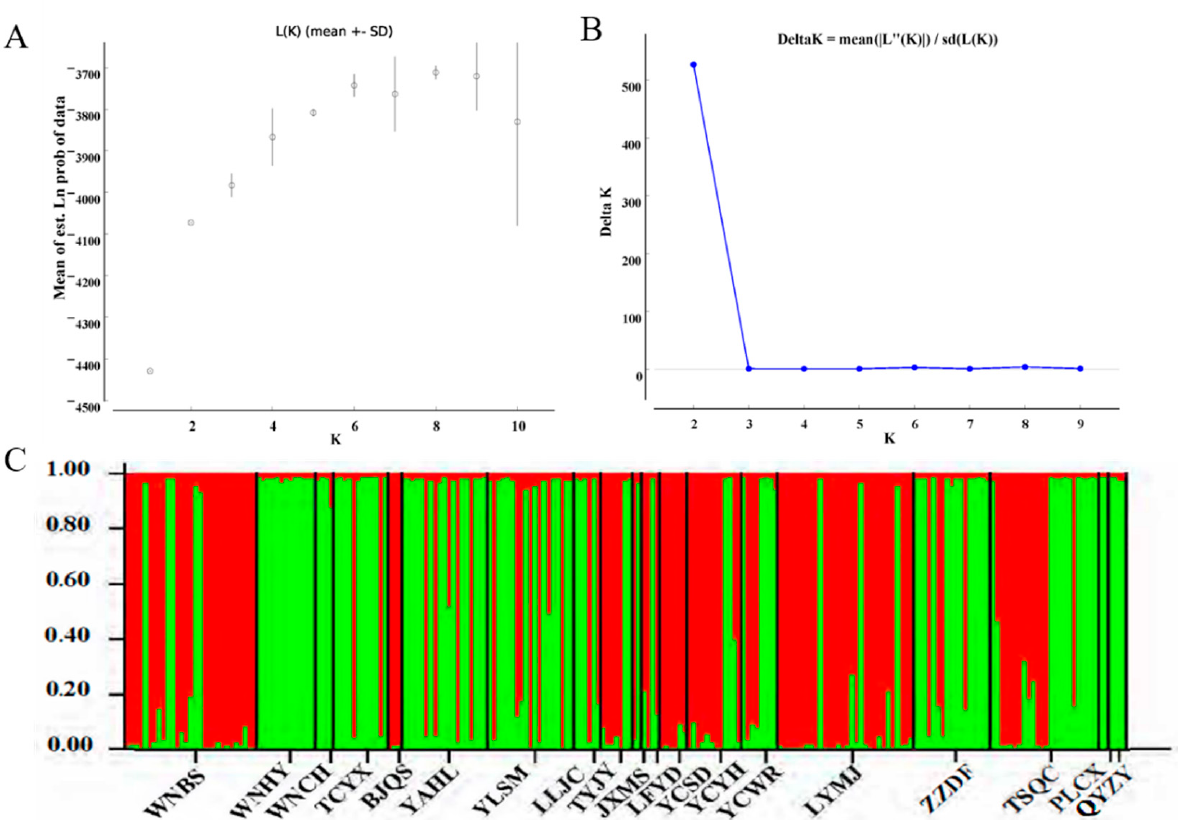
Figure 3. Population structure of 221 ancient P. orientalis genotypes based on 9 nSSR loci data: ( A ) estimation of population using mean of estimated lnP(D) with K values ranging from one to ten; ( B ) estimation of the number of clusters K and the plot of the ad hoc statistic ∆ K calculated for different K values ranging from one to ten following the ∆ K method proposed by Evanno et al. [48]; ( C ) assignment of 221 ancient P. orientalis genotypes to two clusters identified by the program STRUCTURE version 2.3.4.